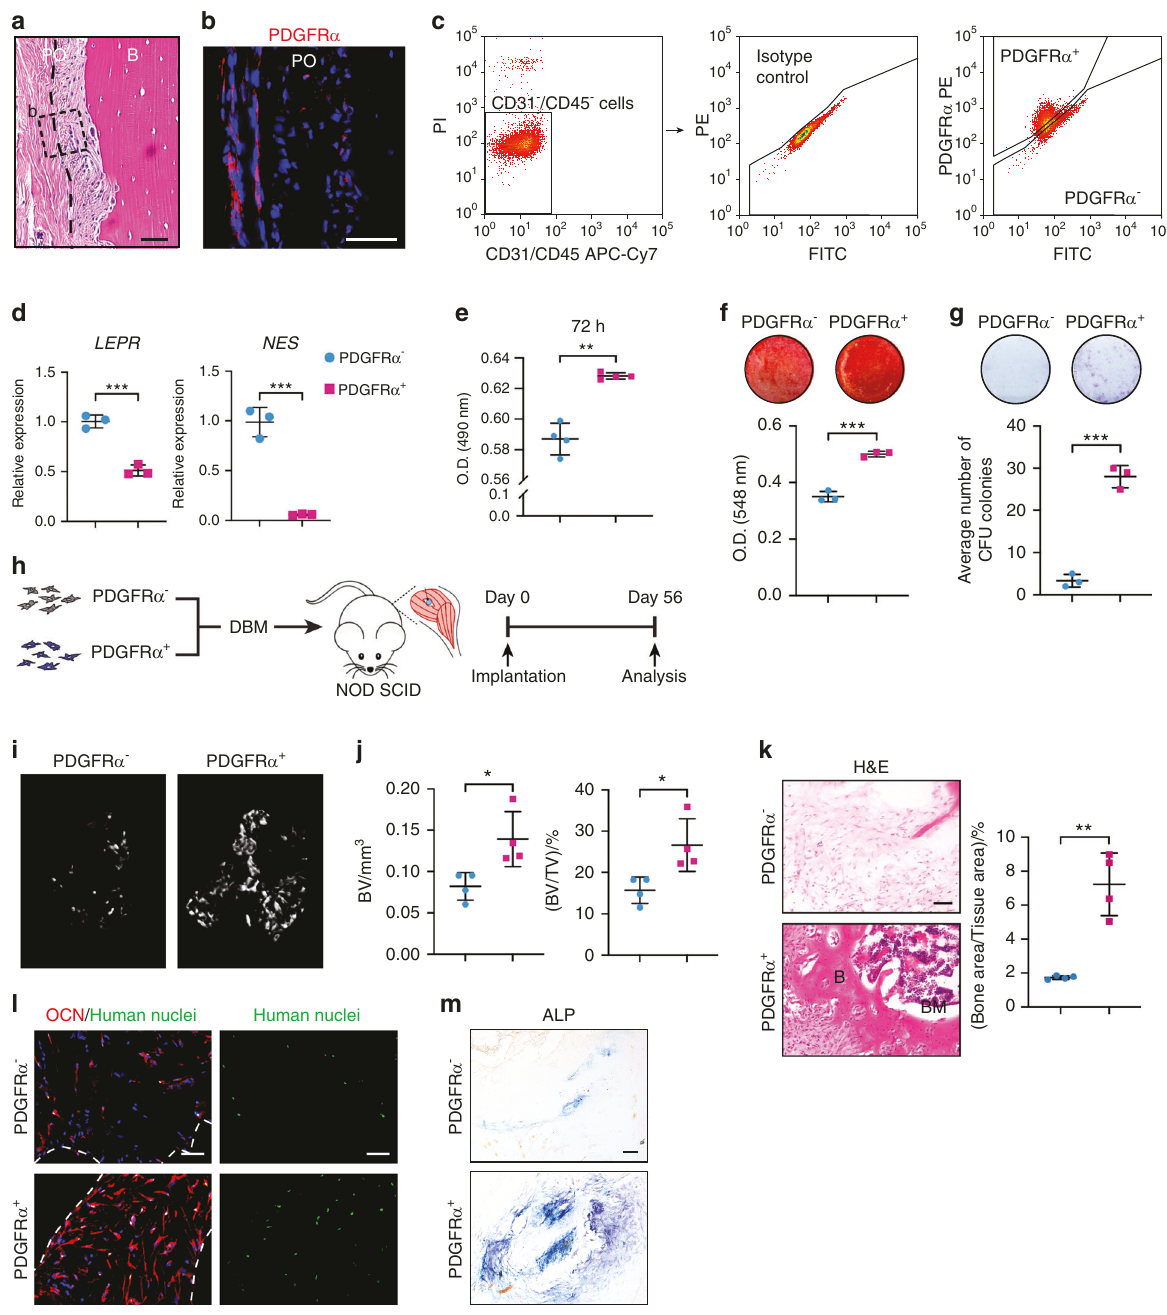
Fig. 6 Human PDGFR α + periosteal progenitors have high osteogenic potential. a Representative histologic appearance of the human periosteum observed by H&E staining. The dashed line indicates the limit between the inner and outer layers of the periosteum. The dashed box indicates the location of b . b PDGFR α immunohistochemistry (shown in red) in human diaphyseal periosteum ( n = 3). Nuclei, DAPI (blue). c PDGFR α − and PDGFR α + cell isolation from the human diaphyseal periosteum. PDGFR α − and PDGFR α + cells were isolated from the CD31 − CD45 − nonendothelial/nonhematopoietic cell population. Isotype control staining is shown. d Progenitor cell markers among human PDGFR α − and PDGFR α + stromal cells from the same patient sample, including leptin receptor ( LEPR ) and Nestin ( NES ), were detected by qRT – PCR. e Cellular proliferation among human PDGFR α − and PDGFR α + periosteal cells at 72 h as assessed by the MTS assay. f Osteogenic differentiation of PDGFR α − and PDGFR α + periosteal cells as assessed by Alizarin Red (AR) staining. g Fibroblast colony-forming units (CFU-Fs) among human PDGFR α − and PDGFR α + periosteal cells. h Schematic of the ossicle assay. PDGFR α − or PDGFR α + cells (3 × 10 6 ) were intramuscularly implanted into NOD SCID mice using a DBX carrier and harvested 8-week later. i Micro-CT reconstructions of the implants. j Quantitative analysis of the micro-CT images of human PDGFR α − and PDGFR α + stromal cells. The analysis included the bone volume (BV) and fractional bone volume (BV/TV). k Representative histologic appearance determined by H&E staining (left) and quanti fi cation of the bone area/tissue area (right). l Immuno fl uorescence staining of osteocalcin (OCN, red) and human-speci fi c nuclei (green) within implants laden with PDGFR α − or PDGFR α + cells. The white dashed lines demarcated the edges of the scaffold. m Representative ALP staining. Scale bars: 50 μ m. B bone, BM bone marrow, PO periosteum. The dot plots represent an individual sample or animal, and the whisker plots indicate the mean and one-SD values. The experiments were performed in triplicate. n = 4 animals per group. * P < 0.05, ** P < 0.01 and *** P < 0.001, as assessed by two-tailed Student ’ s t